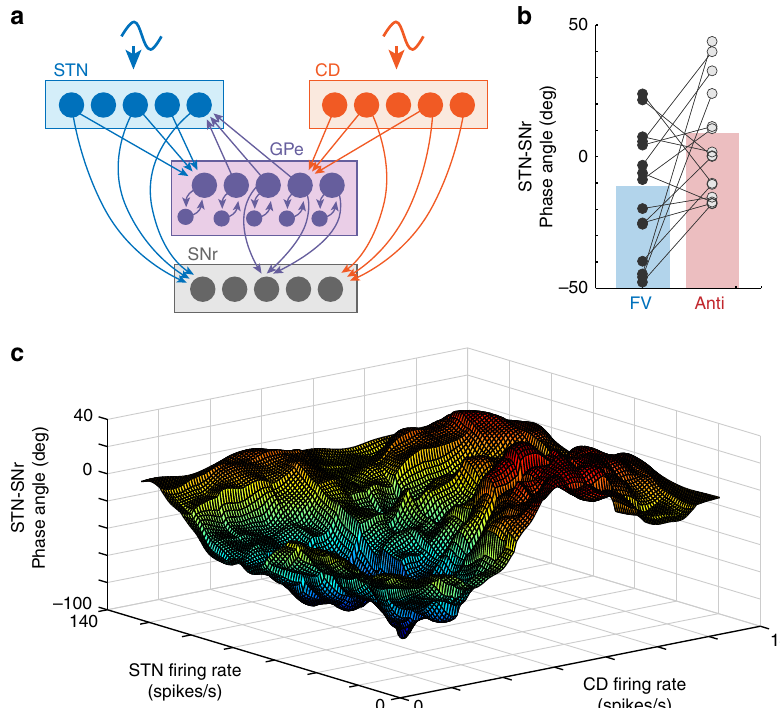
Fig. 7 Basal ganglia neural networks model of STN-SNr phase angle according to STN and CD activation. A simple spiking neural networks model of the BG was created to test whether altering the input activation of the STN and CD could result in an STN-SNr phase angle shift. Each nucleus ( “ node ” ) contained 1000 arti fi cial neurons (McCulloch-Pitts neuron 54, 55 ), which projected to other nuclei according to major BG projection pathways 1 – 3, 11, 31 . Anatomical localizations of projection neurons within each nucleus were assigned randomly. a Color-coded schematic of BG spiking neural networks model architecture, indicating all modeled projection pathways (hyperdirect, direct, indirect, subthalamo-pallidal-nigral, and recurrent GPe inhibitory layer). b Phase angle differences in arti fi cial STN-SNr signals was similar to those observed in LFP recordings (Fig. 2b), at published estimates of STN 7, 56 and CD 8, 57, 58 activities in free viewing and goal-directed saccade conditions (STN = 3 Hz/45 Hz, CD = 3 Hz/20 Hz, for free viewing and goal-directed conditions, respectively). c STN-SNr phase angle across all combinations of STN and CD fi ring rates from 0 to 100 spikes/s revealed a robust shift in STN- SNr phase angle between low and high STN/CD activation